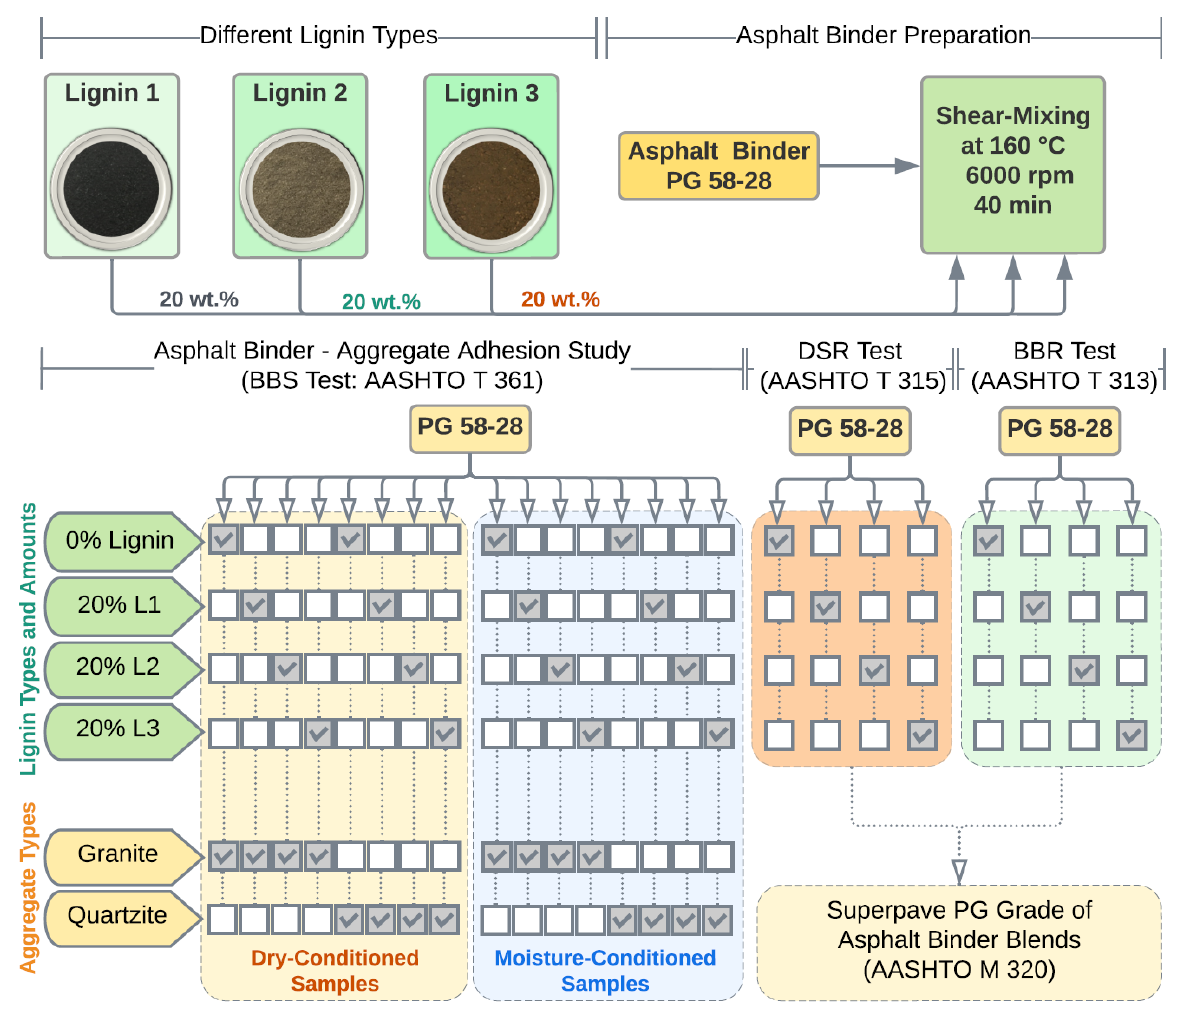
Figure 1. Work Flow and Test Matrix.